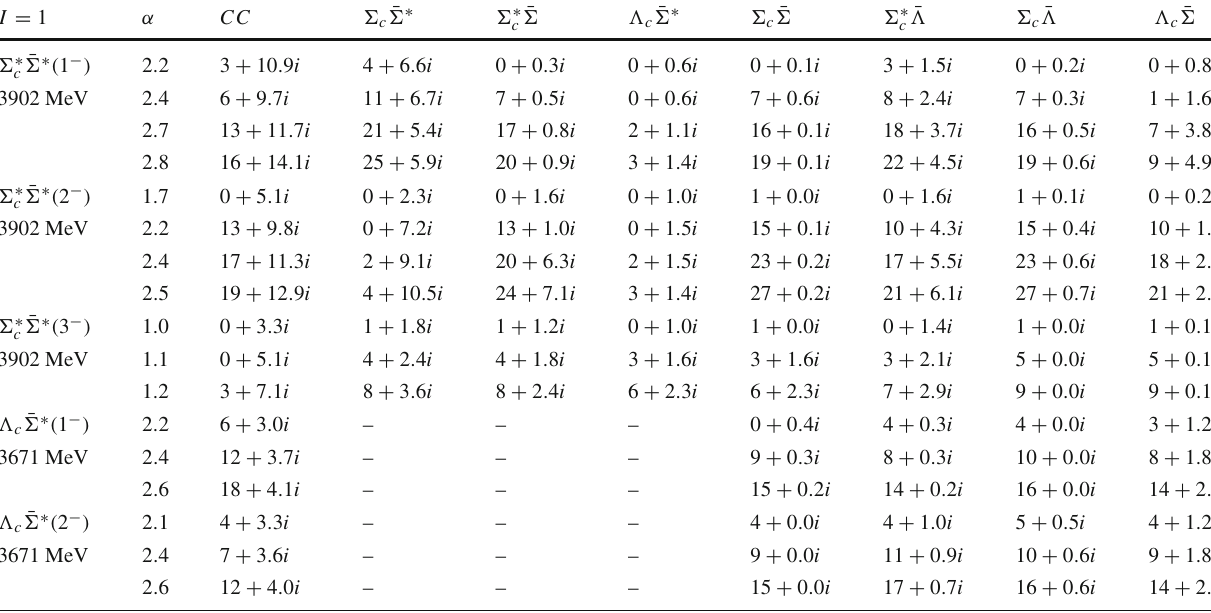
Table 8 The masses and widths of isovector charmed-antistrange molecular states at different values of α . Other notations are the same as Table